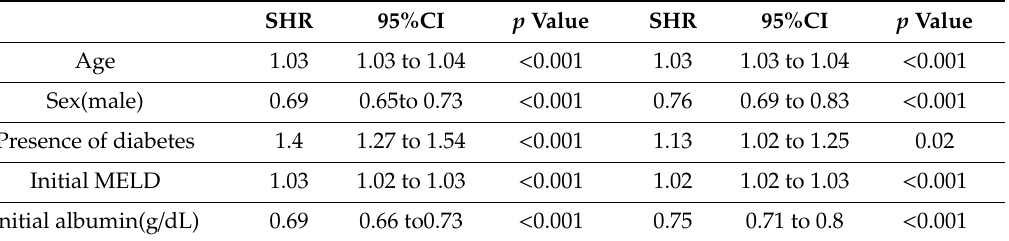
Table 4. Competing risk analysis of time to death or waitlist removal for clinical deterioration with transplant as competing